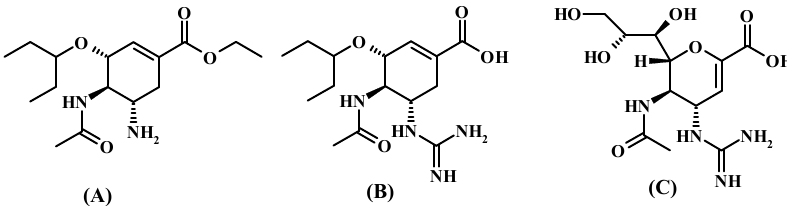
Figure 1. Chemical structures of: ( A ) oseltamivir carboxylate; ( B ) guanidated oseltamivir carboxylate and ( C ) zanamivir.